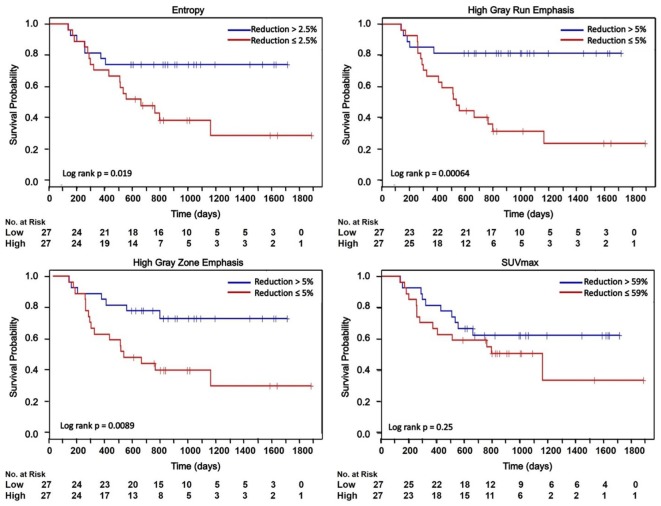
Kaplan–Meier curves dichotomized based on the median of ΔTextures and ΔSUVmax. HGRE, high-gray-run emphasis; HGZE, high-gray zone-run emphasis; SRHGRE, Short-run high-gray-run emphasis; SZHGE, short-zone high-gray-run emphasis. + indicates censored data.